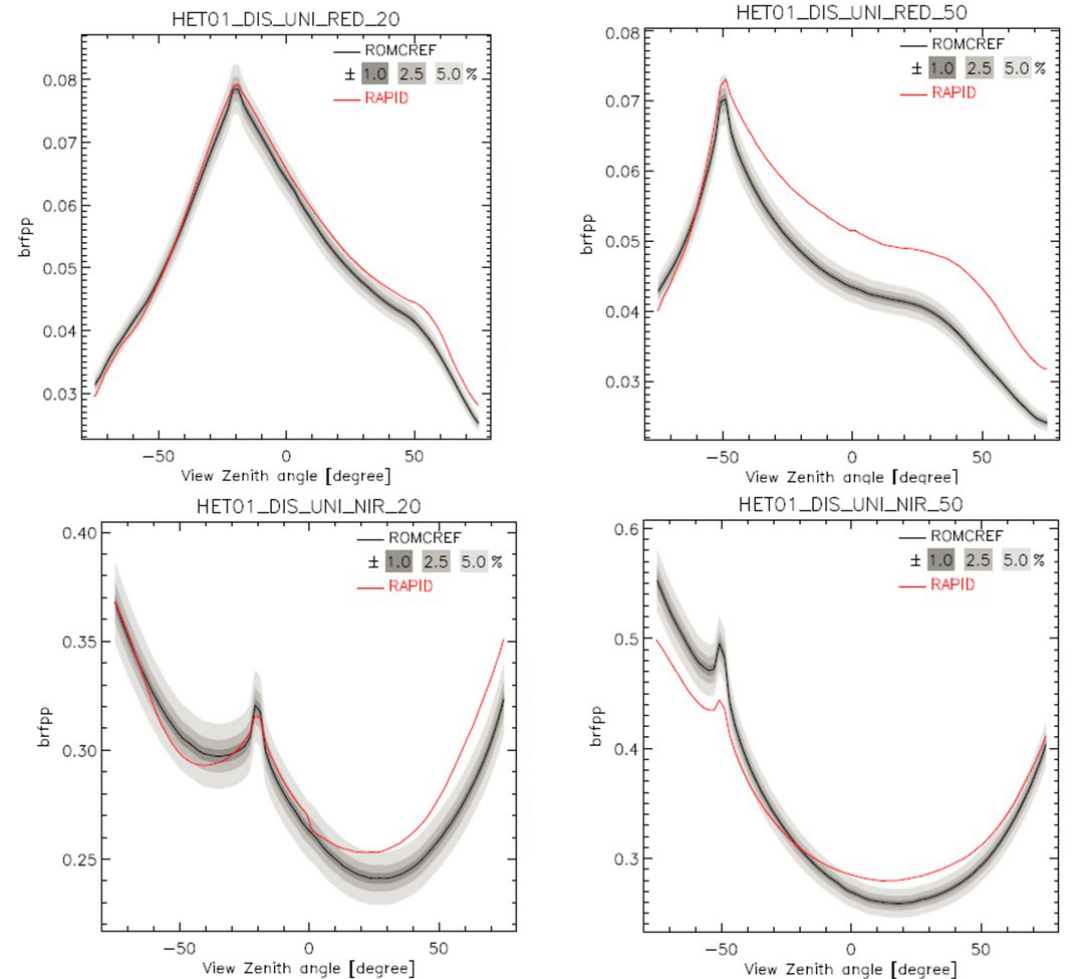
Figure 10. Comparisons of HET01 BRF results in the principal plane (brfpp) with the reference data from the RAMI online checker (ROMCREF).